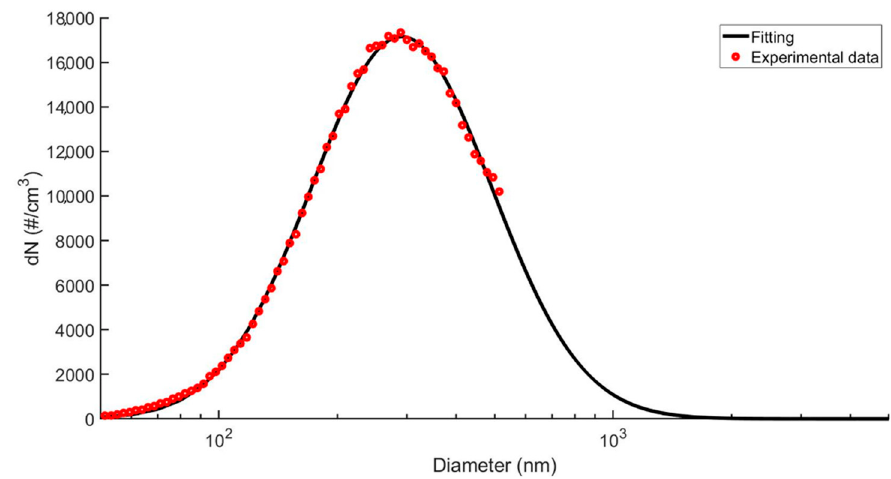
Figure A1. Particle size distribution of the liquid aerosol.